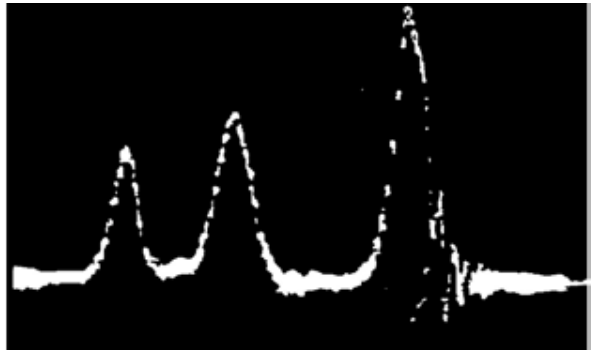
Figure 2. First reported proton NMR spectrum 1 spectrum of ethyl alcohol. Reprinted from Ref. 6, with the permission of AIP